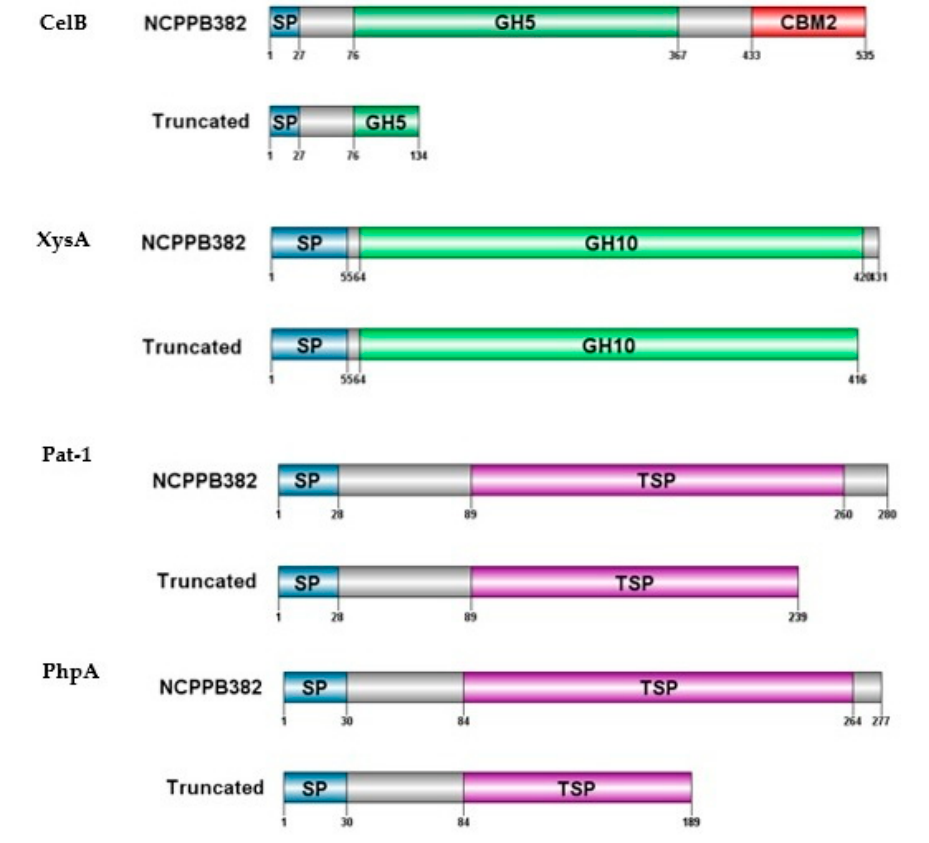
Figure 5. Representation of truncated proteins based on deletions detected in virulence gene se- quences. SP: signal peptide; GH5: glycosyl hydrolase 5; CBM2: carbohydrate binding module; GH10: glycosyl hydrolase 10, TSP: trypsin serine-protease. Table 4. Identity, coverage, and detection of deletions in virulence genes celA, celB, pelA1, pelA2, xysA, xysB, pat-1, phpA, and phpB of Chilean Clavibacter michiganensis subsp. michiganensis strains based on their genome